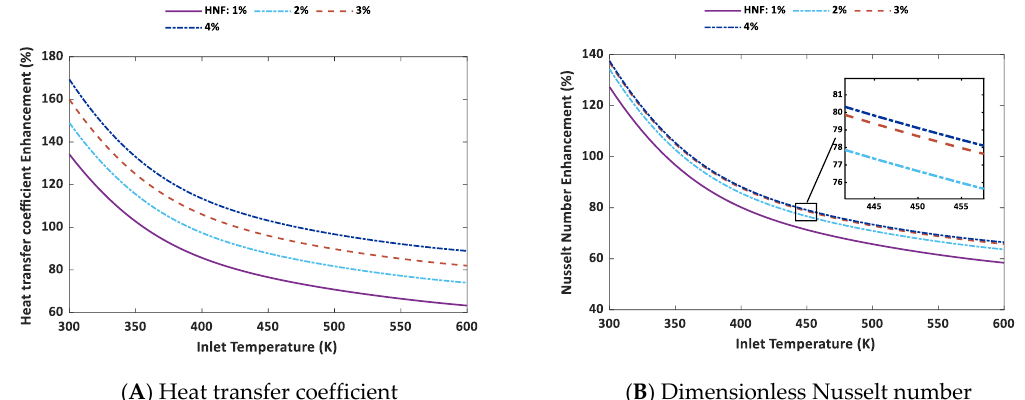
Figure 7. The 3D representation for the ( A ) heat transfer coefficient and ( B ) Nusselt number versus concentrations and temperatures.